Question: What form of chart is displayed?
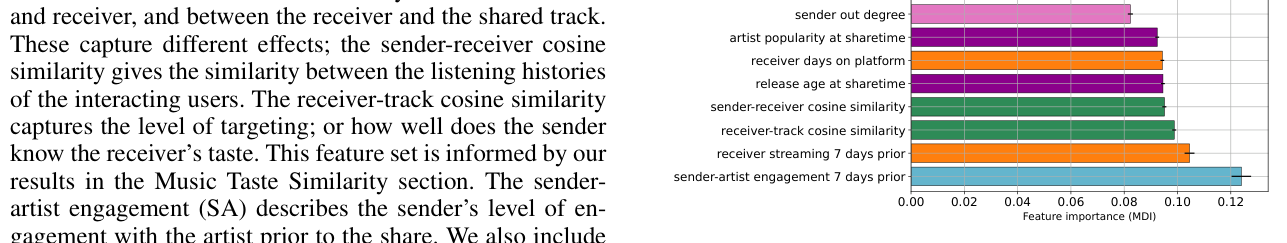
Answer: bar